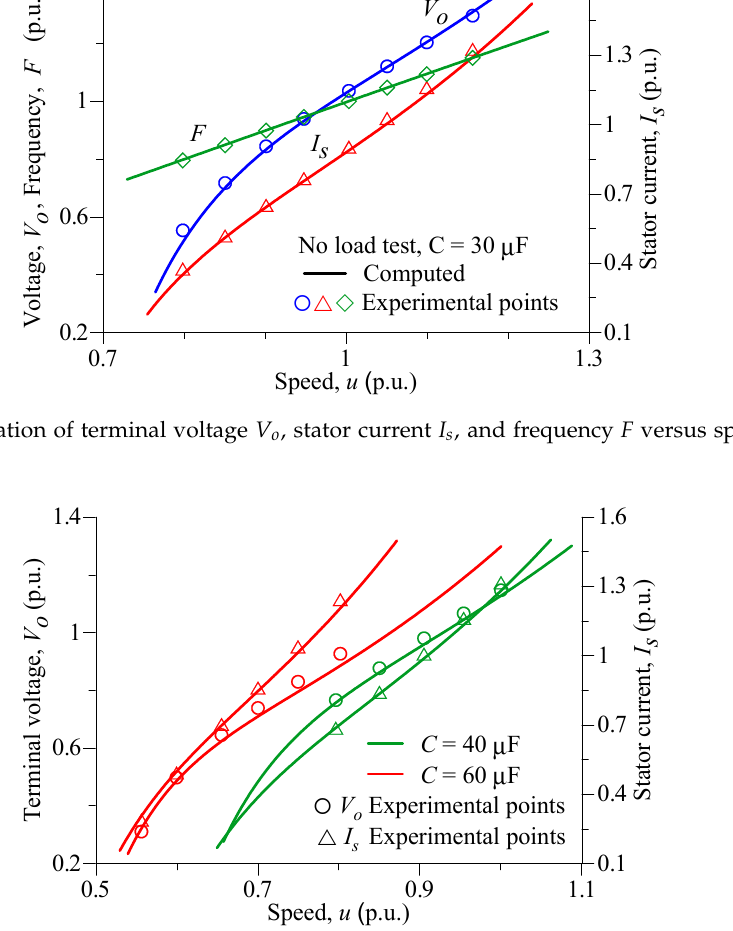
Figure 15. Terminal voltage V o , and stator current I s versus speed under no load.